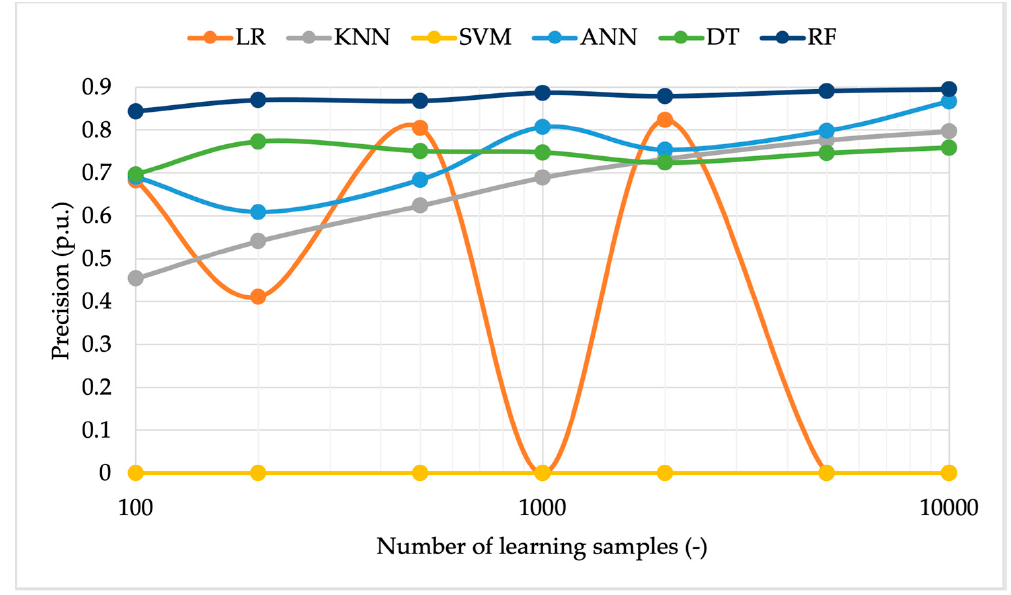
Figure 7. Algorithm precision vs. the number of learning samples using uniform distributed in- puts.